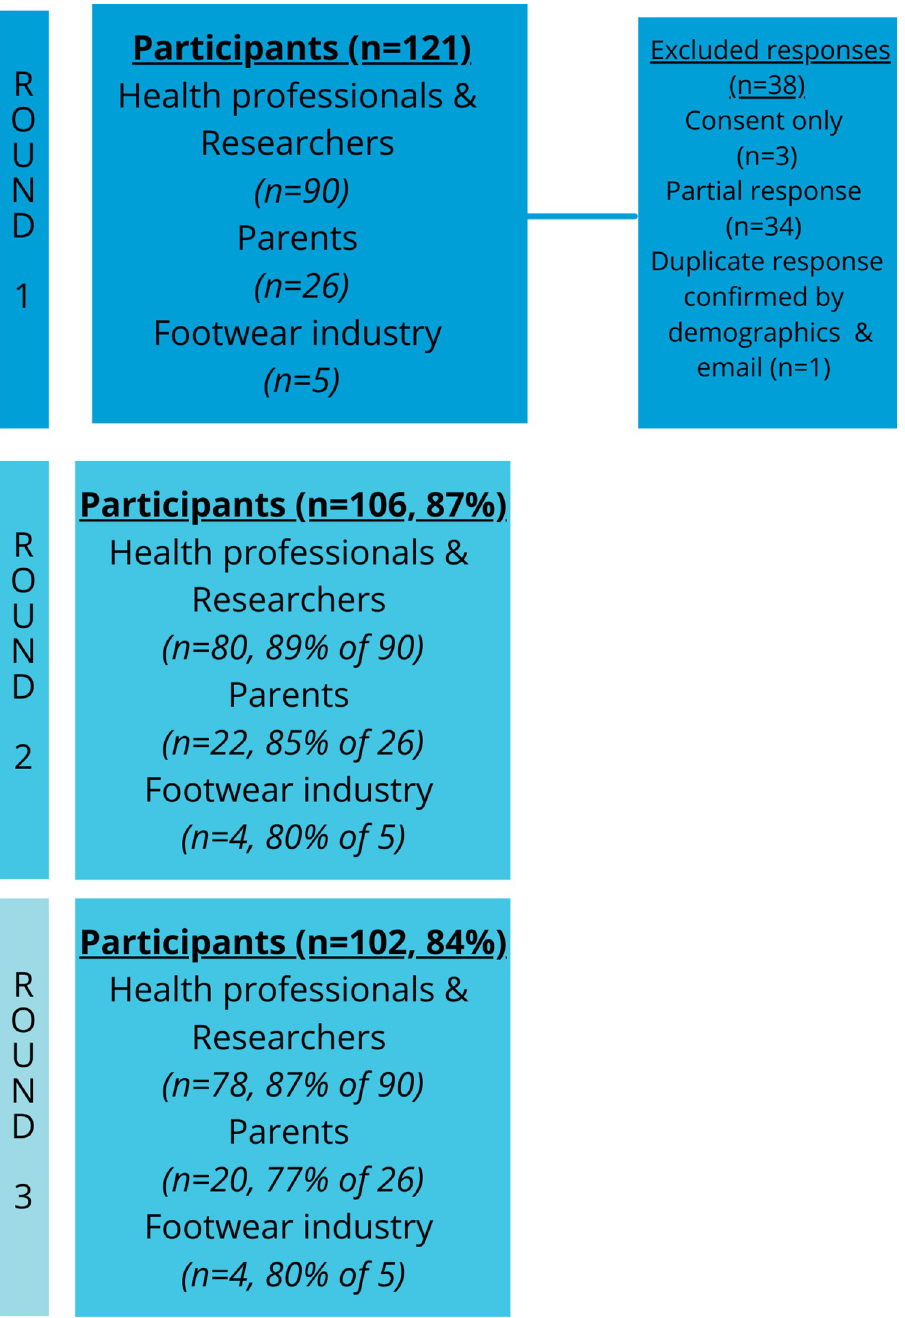
Fig 3. Participant flow through